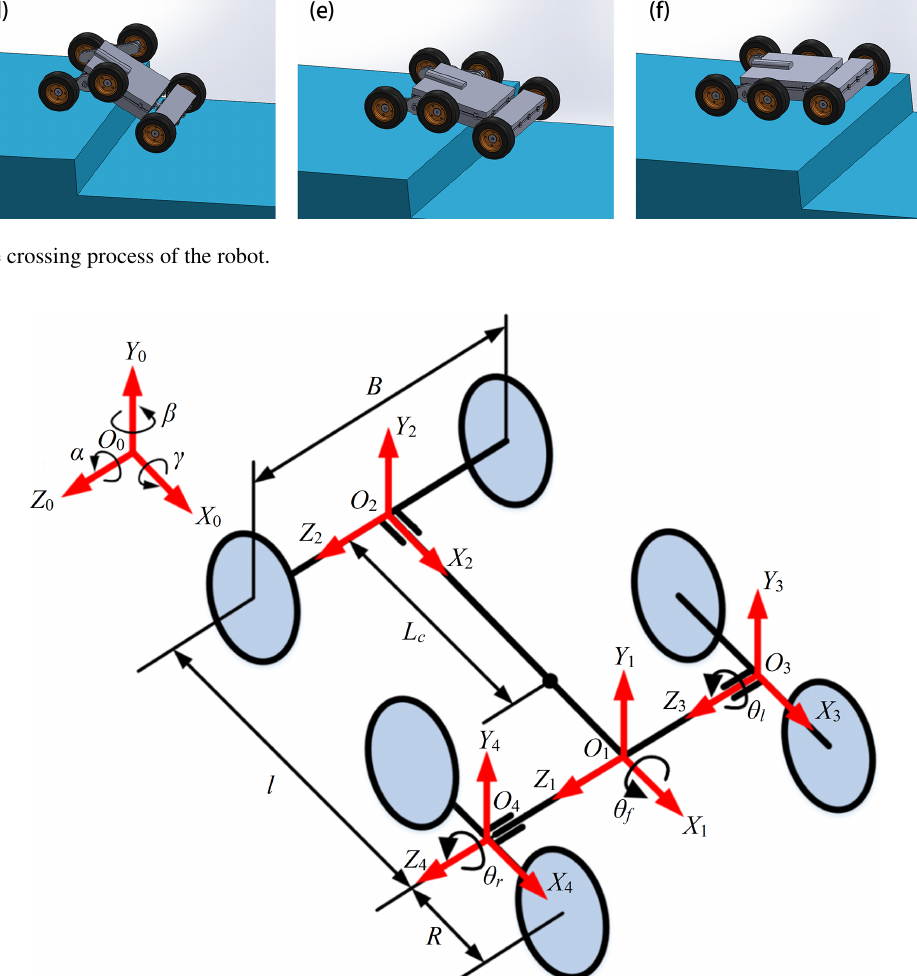
Figure 6. Schematic diagram and geometrical parameters of the